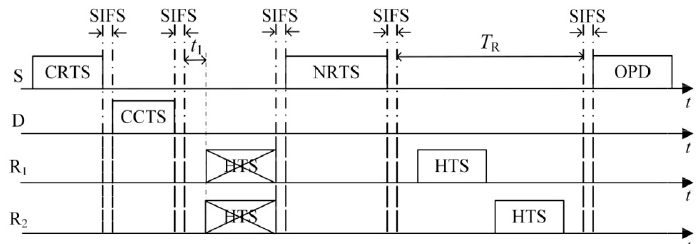
Figure 5. Third case of optimalcooperative node group: help-to-send (HTS) packet transmission collisions occur.